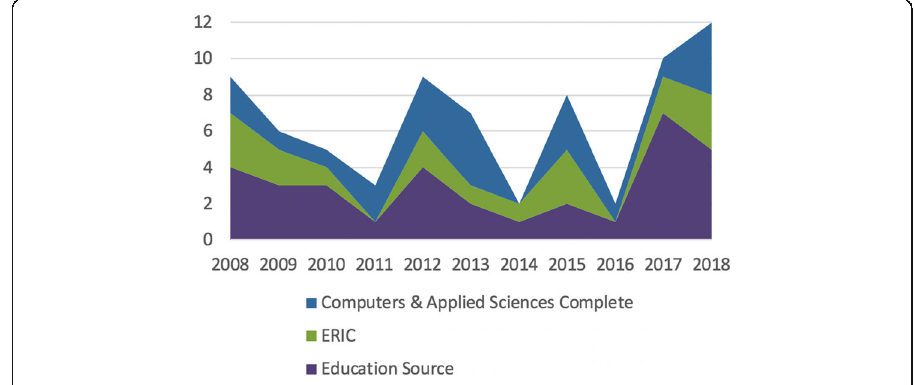
Fig. 4 Number of included papers by database and